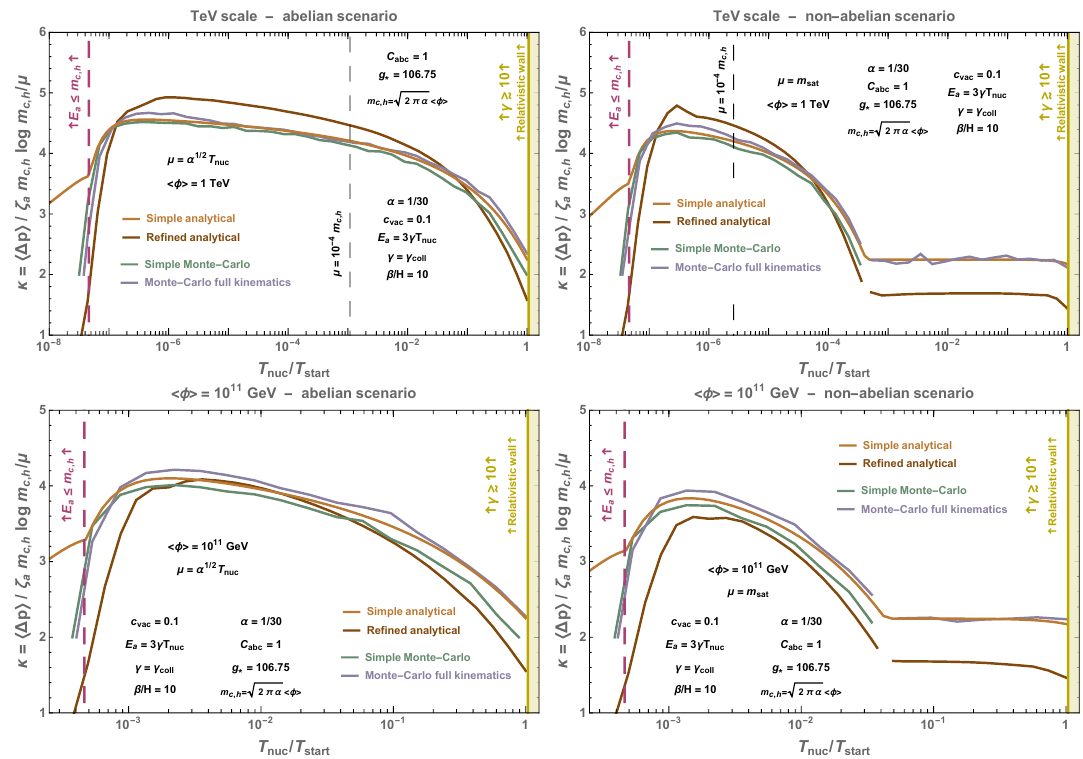
Figure 12 . We compare different schemes for computing the exchange momentum ∆ p induced by splitting radiation resummed at all leading-log orders, both at the analytical and at the numerical level. The analytical estimates shown in orange and brown correspond to the 1st and 7th level of correction of table 2. The green and gray lines show the results from the Monte-Carlo simula- tions, see section 5, using either the soft-collinear-single-plane-emission-no-transverse-recoil limit in eq. (4.5) (green line) or the more refined prescription presented in appendix B.3 (gray line). The most refined schemes of our work, shown in brown and gray lines, do not account for the same corrections, and so they are complementary to each